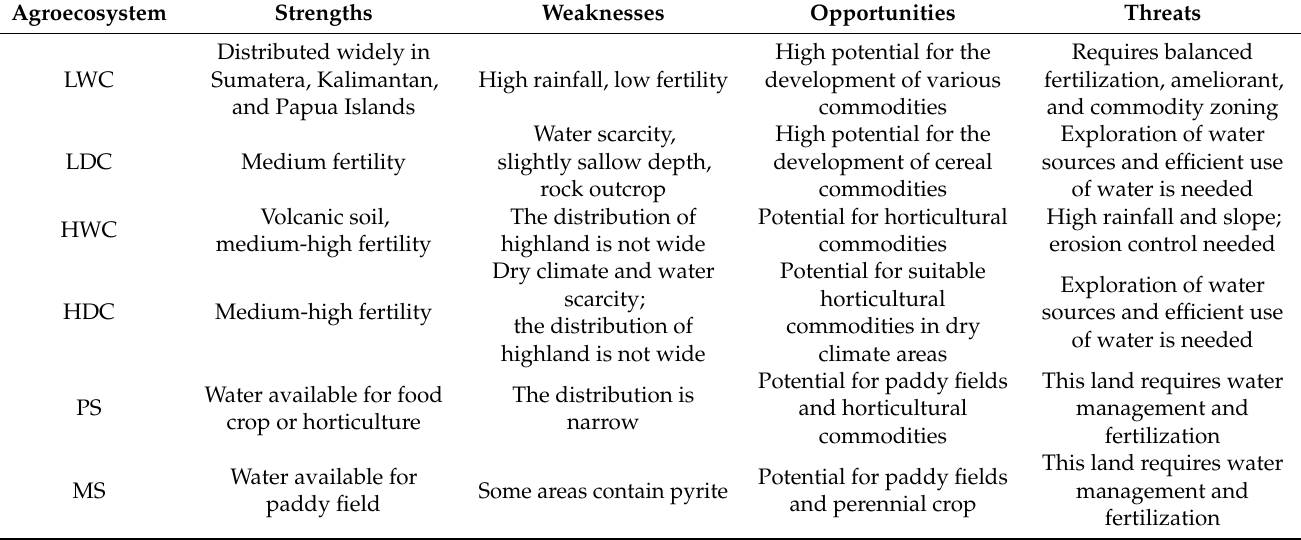
Table 7. SWOT analysis of AL in each